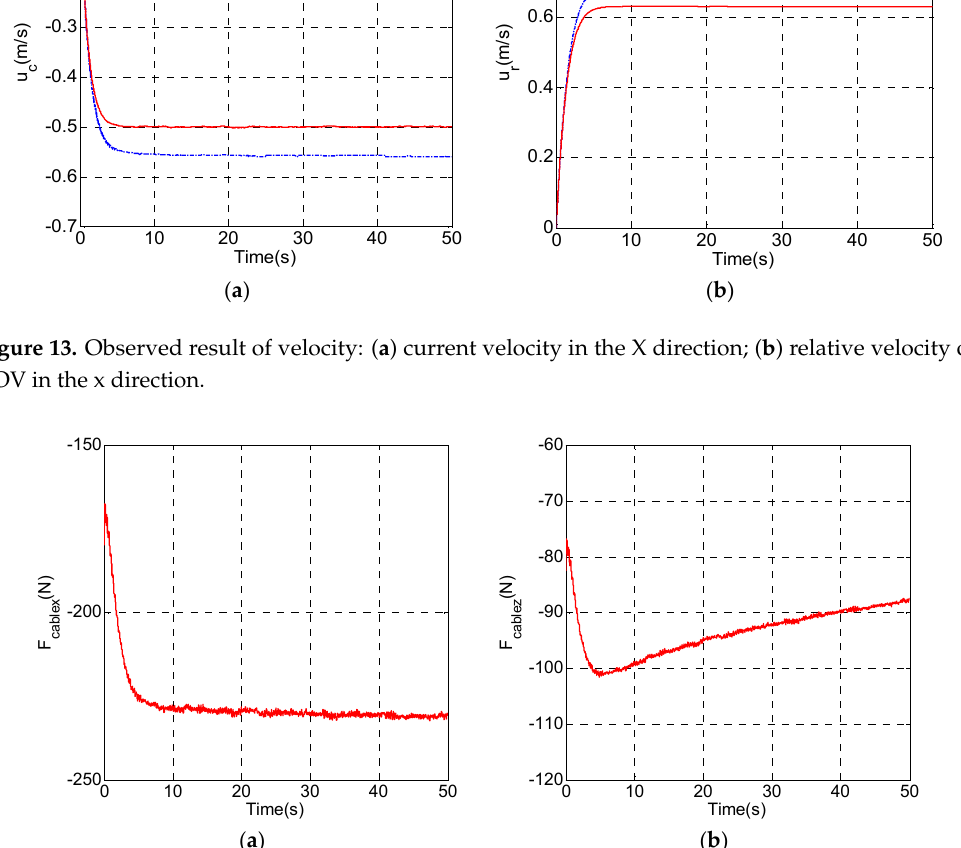
( b ) Figure 16. Observed error of velocity and position: ( a ) velocity error; ( b ) position error. 6.4. Observer Simulation under Conditions of Cable Disturbing Force with Compensation To observe the effects of the cable disturbing force compensation on the performance of the observer, the cable force is considered in the ideal ROV model. The cable disturbing force mentioned above is generated by using the lumped parameter method, regarded as the true value in practical environments. The initial cable shape in the vertical plane is shown in Figure 17. The observer simulation is conducted under the conditions of a cable disturbing force with disturbance compensation. The parameters of the observer remain unchanged,